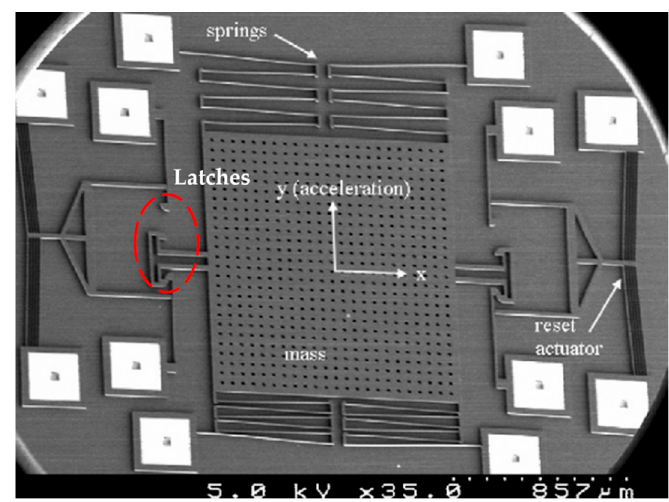
Figure 7. A switch with mechanical latches and reset actuators in the sensitive directions [31].